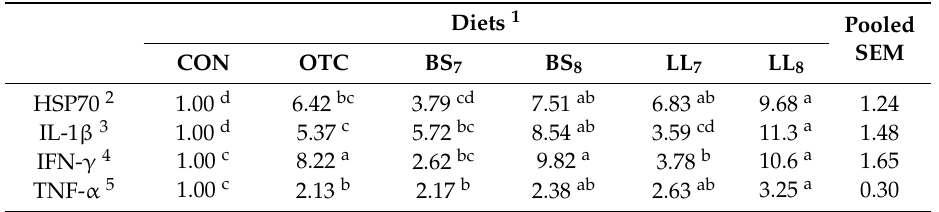
Table 8. Intestinal gene expression levels of juvenile Nile tilapia fed the experimental diets for 8